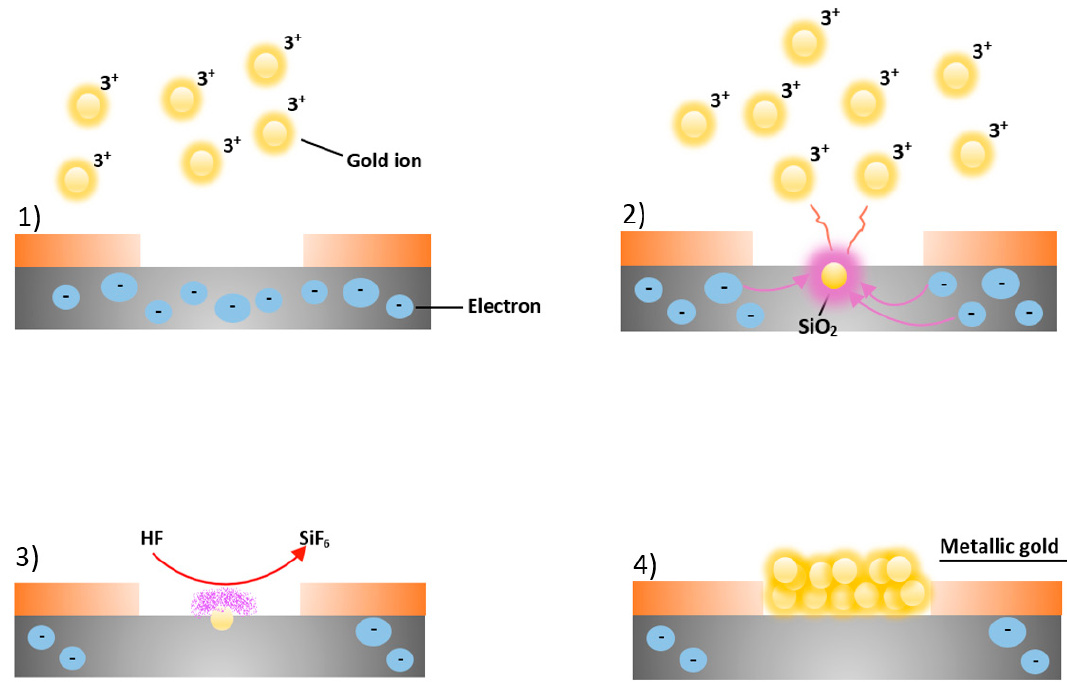
Figure 3. Schematic representation of electroless deposition of gold nanoparticles. ( 1 ) Au 3+ ions in the solution near the silicon (Si) surface (in grey), in the proximity of the nanoholes patterned in the resist (in orange), capture electrons from the Si valence band; ( 2 ) a redox reaction starts between gold ions and Si, evolving in the Au 3+ reduction into metallic gold nanoparticles and the oxidation of silicon into SiO 2 ; ( 3 ) the hydrofluoric acid in solution reacts with the silicon oxide inducing the etching of SiO 2 and the dissolution of it as SiF 62- (violet cloud); ( 4 ) the Au nuclei deposited continue to attract electrons from bulk silicon, working as a catalytic surface for the reduction of new Au 3+ ions until the desired thickness is reached.